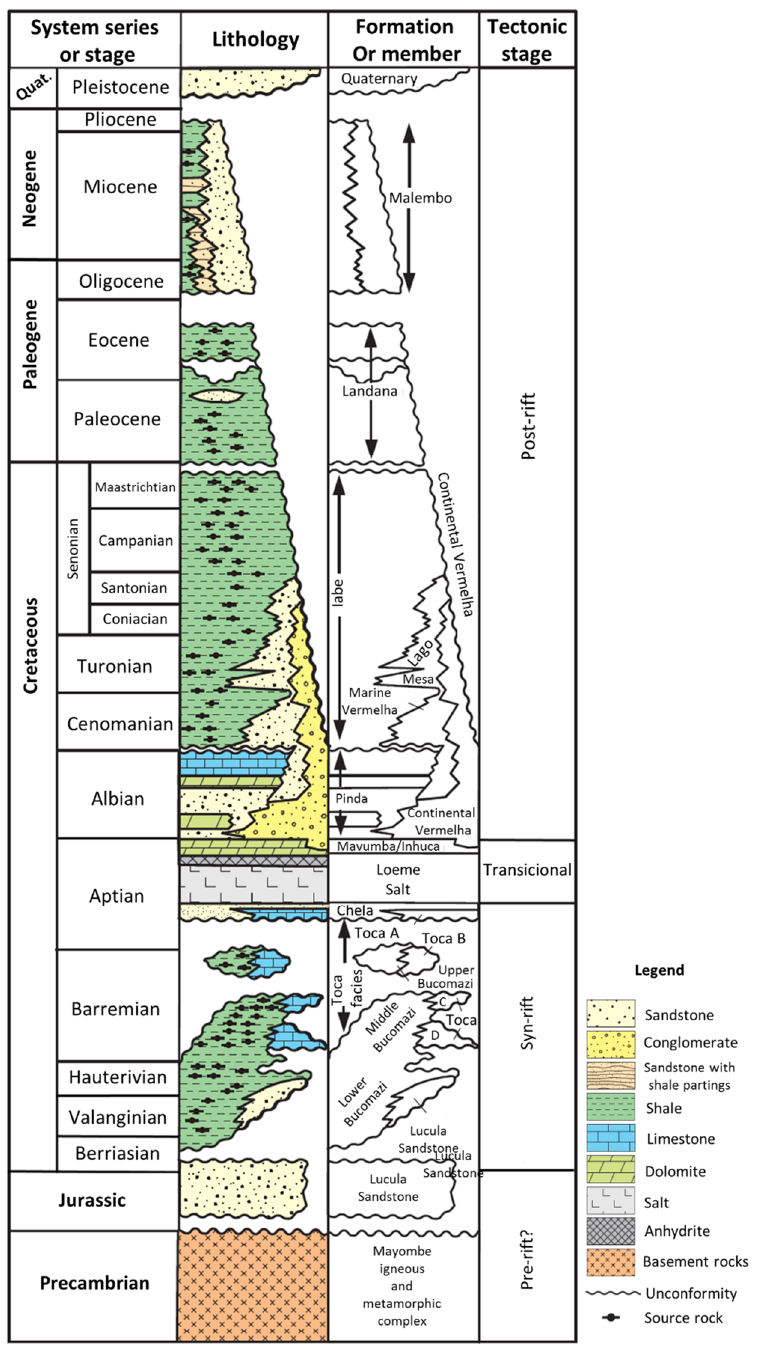
Figure 2. Stratigraphic column in the Lower Congo Basin.